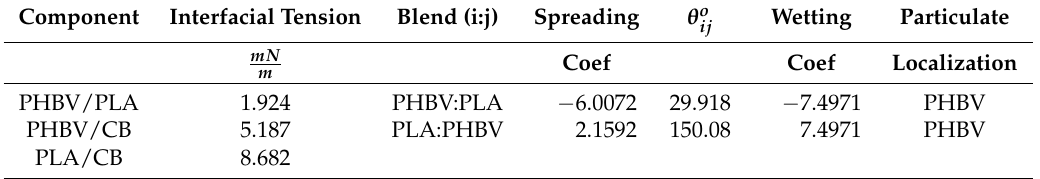
Table 4. Interfacial tension and spreading coefficients between polymers and nanofiller.